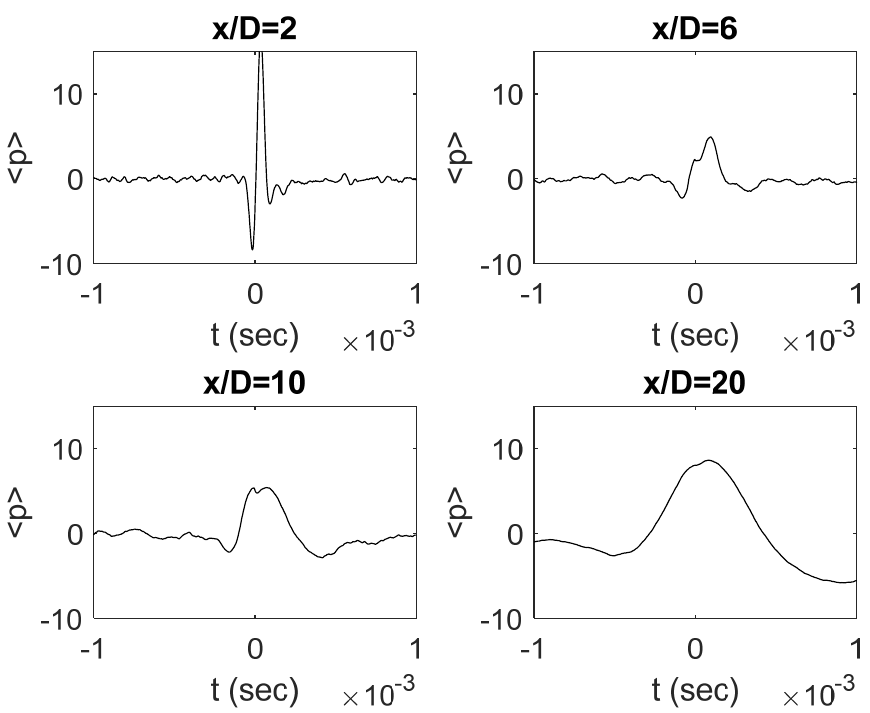
Figure 4. Same as previous plot but at M = 0.9.